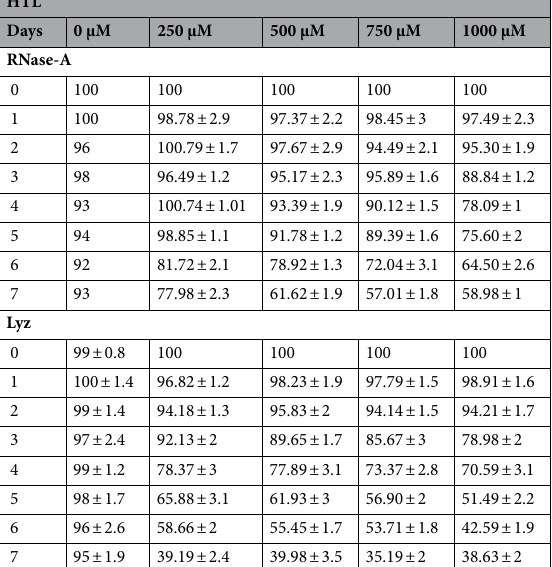
Table 3. Enzyme activity of HTL-modified RNase-A and Lyz: percent enzyme activity of HTL-modified RNase-A and Lyz at intervals of 24 h for seven days. Errors in enzyme activities of RNase-A and Lyz are 5–8% and 4–9%